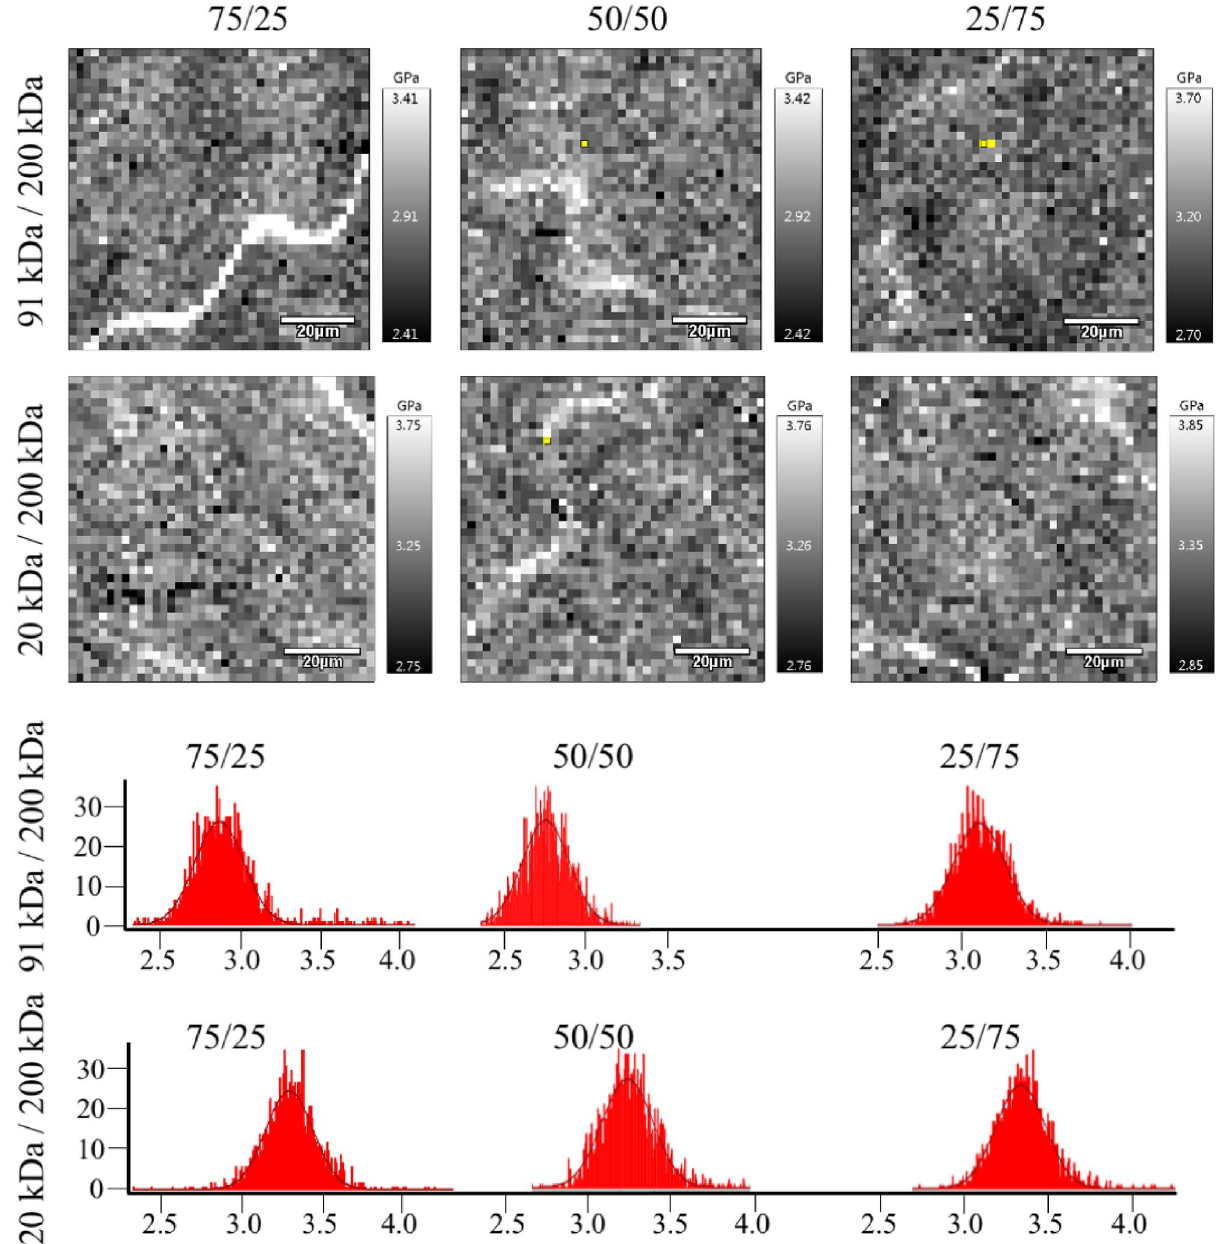
Figure 7. Force spectroscopy maps of bimodal MWD coatings and corresponding histograms of the elastic modulus. The greyscale shows the stiffness—the white colour corresponds to the highest stiffness. The grayscale range is ± 1